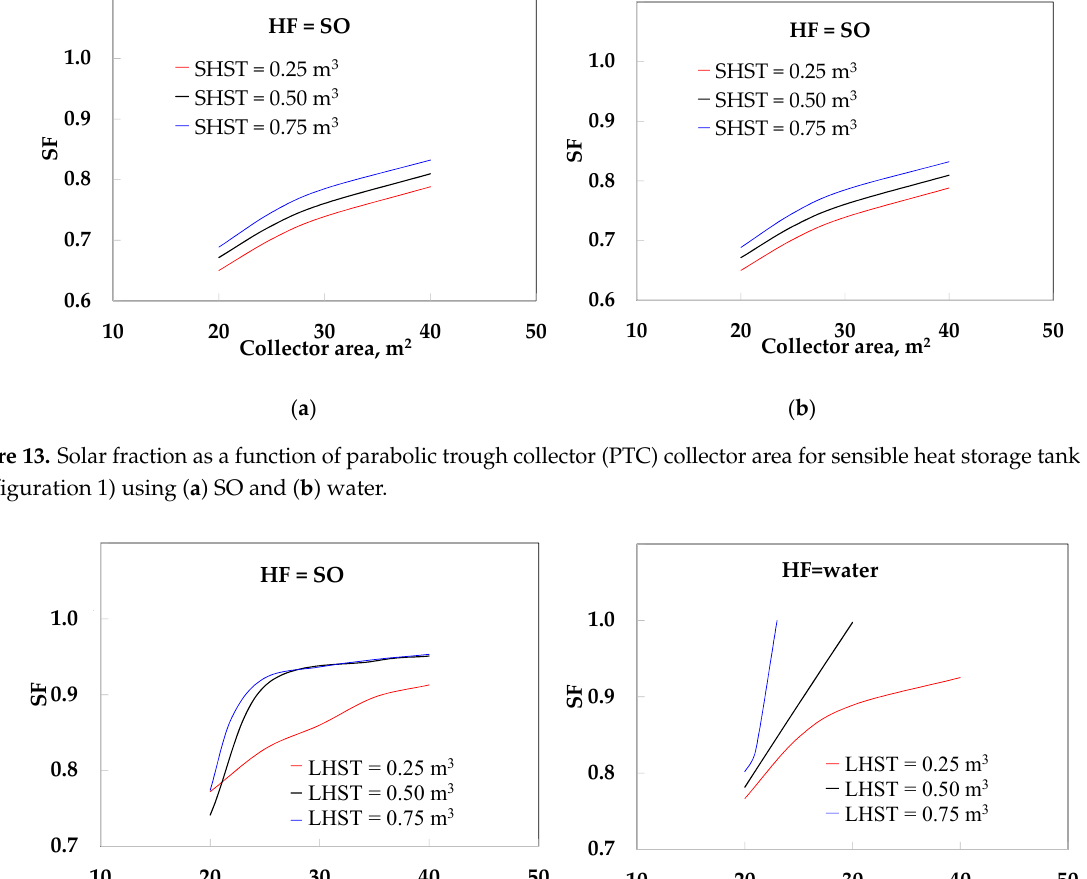
Figure 13. Solar fraction as a function of parabolic trough collector (PTC) collector area for sensible heat storage tank (SHST) (configuration 1) using ( a ) SO and ( b ) water.